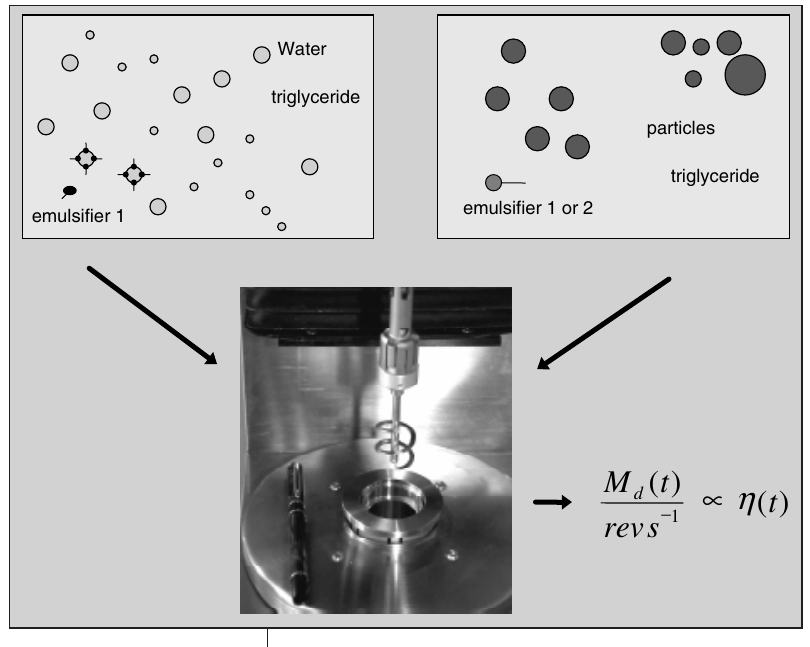
Figure 2: Rheometric mixing of a suspension and an